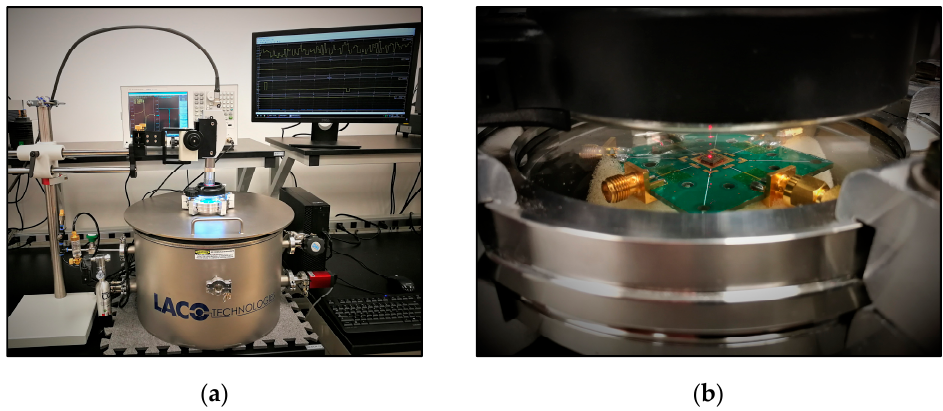
Figure 7. ( a ) Setup for the quartz crystals and the resonator characterization, ( b ) close-up of the micro-resonator during the characerizacion with the laser from the vibrometer visible on the micro-resonator die.